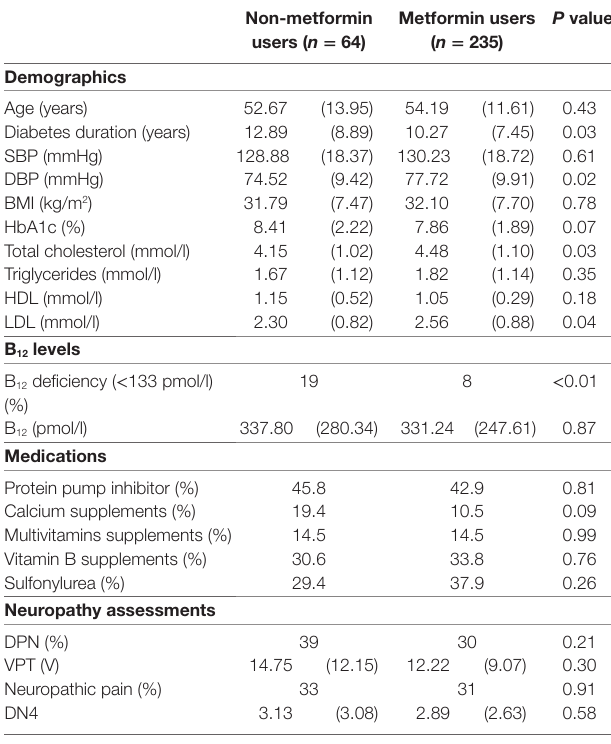
TaBle 1 | Comparison of demographic and clinical characteristics between non-Metformin users and Metformin users. non-metformin users ( n = 64)